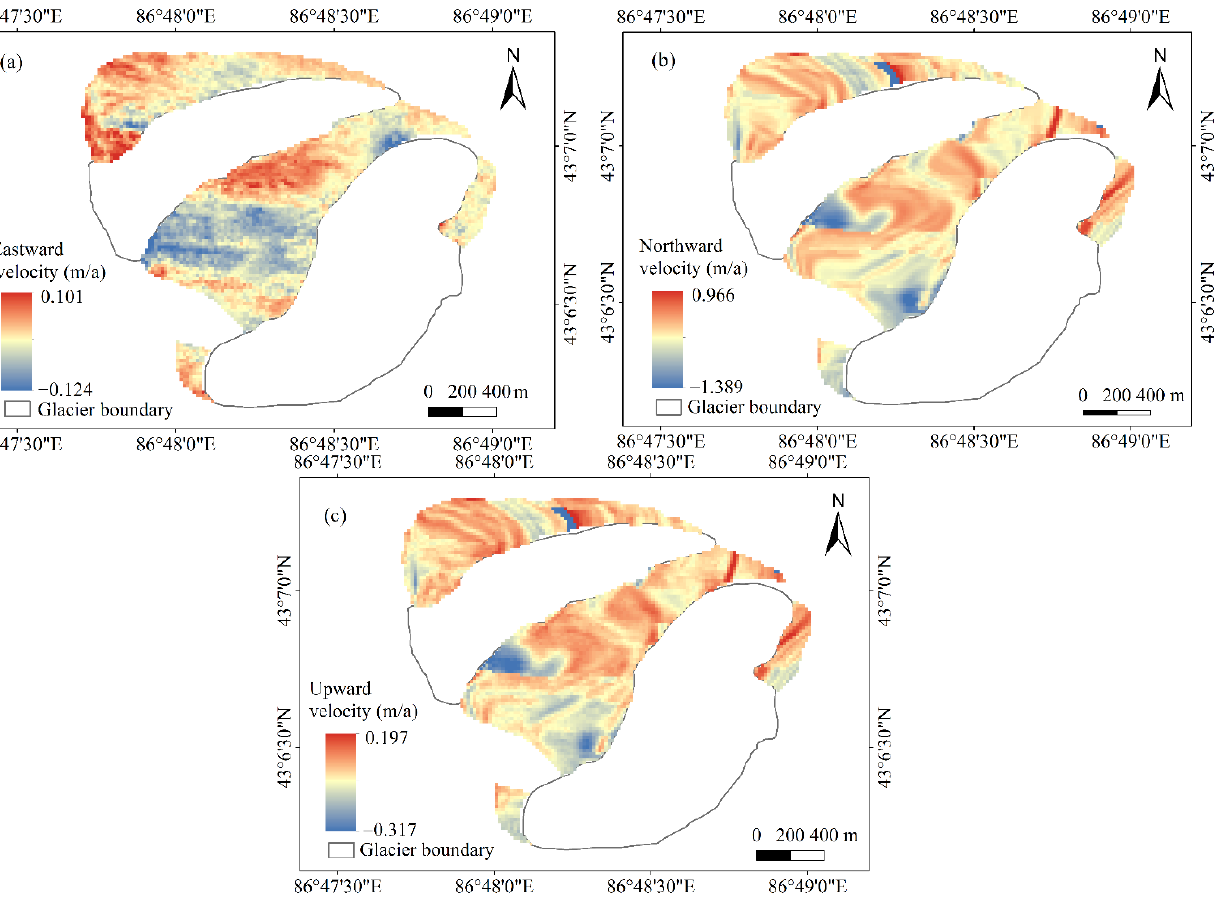
Figure 9. Glacier flow velocity error in the non-glacial region. ( a ) Eastward velocity error; ( b ) Northward velocity error; ( c ) Upward velocity error.